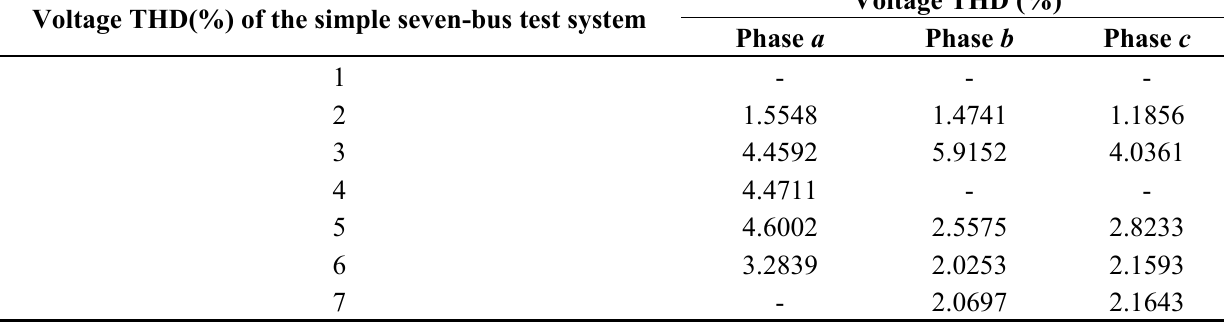
Table 6. Voltage total harmonic distortion (THD) (%) of the simple seven-bus test system.